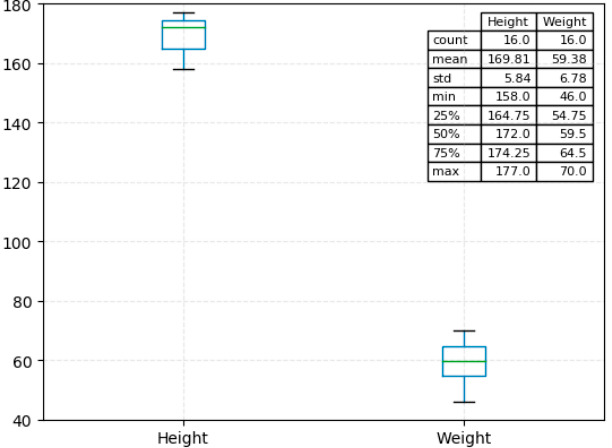
Figure 1. Information about volunteers participating in this experiment.